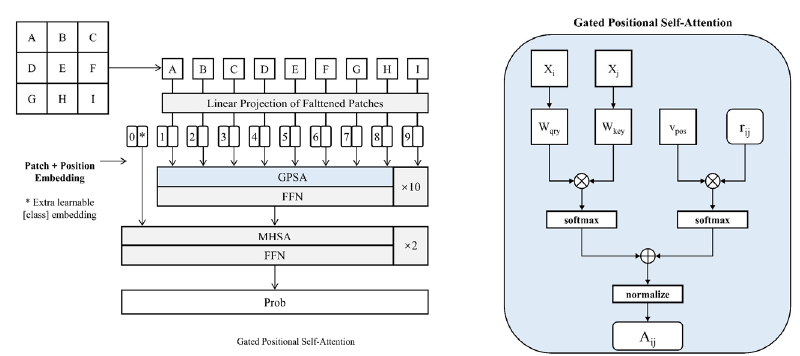
Figure 6. ConViT network structure.